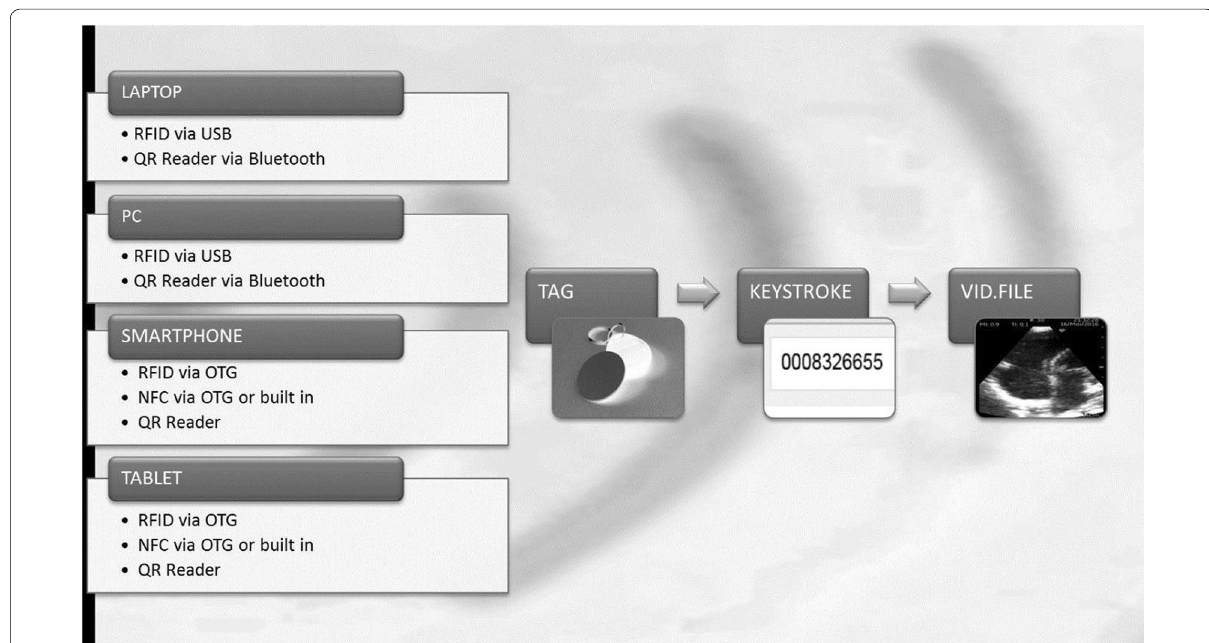
Fig. 1 Different devices such as laptop computers, desktop computers/PCs, smartphones as well as tablets can be used to display video files, that is, ultrasound loops, respectively. These are triggered by tags, the content of which is read as a keystroke. RFID radio-frequency identification, USB